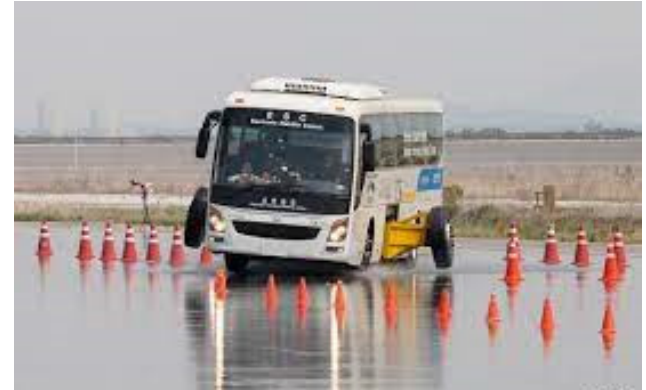
Figure 8. Rollover principle test using equipment of commercial vehicle ESC.